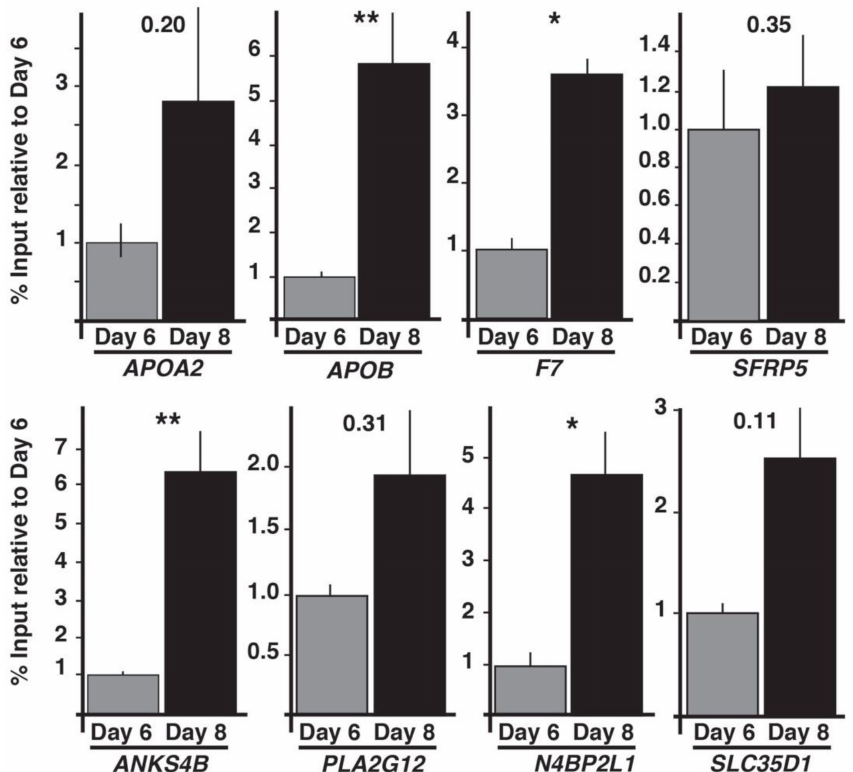
Figure 6. RNA polymerase II (RNA pol II) is recruited to HNF4A target genes coincident with the onset of expression. Bar graphs showing the results of ChIP-qPCR analysis of RNA pol II occupancy of HNF4A target genes during the transition of the endoderm (day six, grey bars) to a hepatic fate (day eight, black bars). For all graphs error bars = s.e.m., n = 3 independent differentiations. Student’s t -test, (*) p ≤ 0.05. (**) p ≤